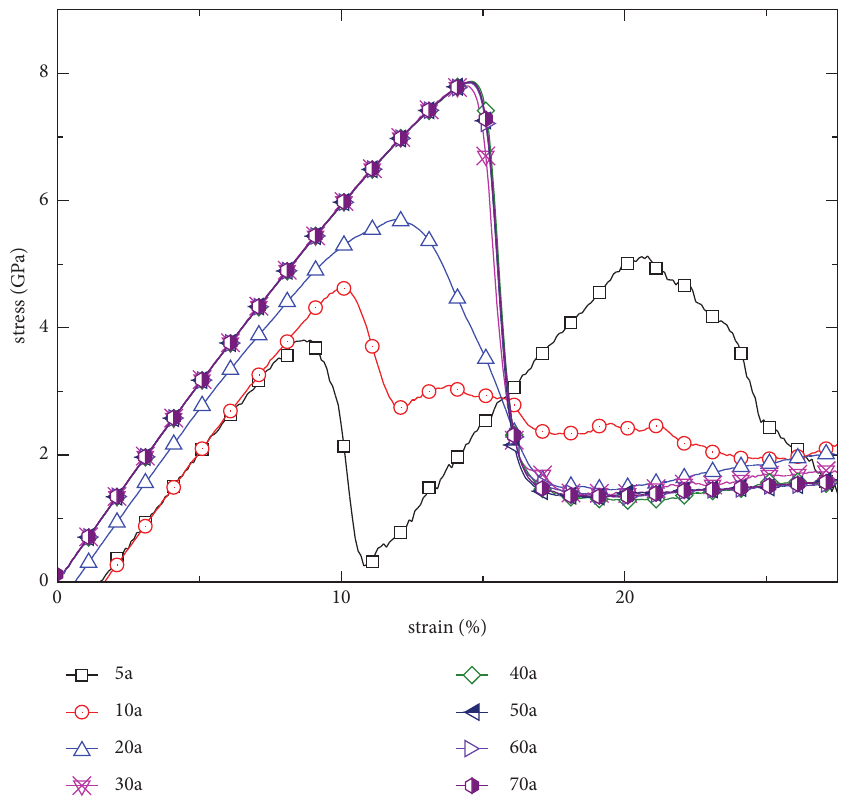
Figure 1: The stress-strain curves of boxes with different sizes such as 5 a , 10 a , ... 70 a , where a � 0.405nm.